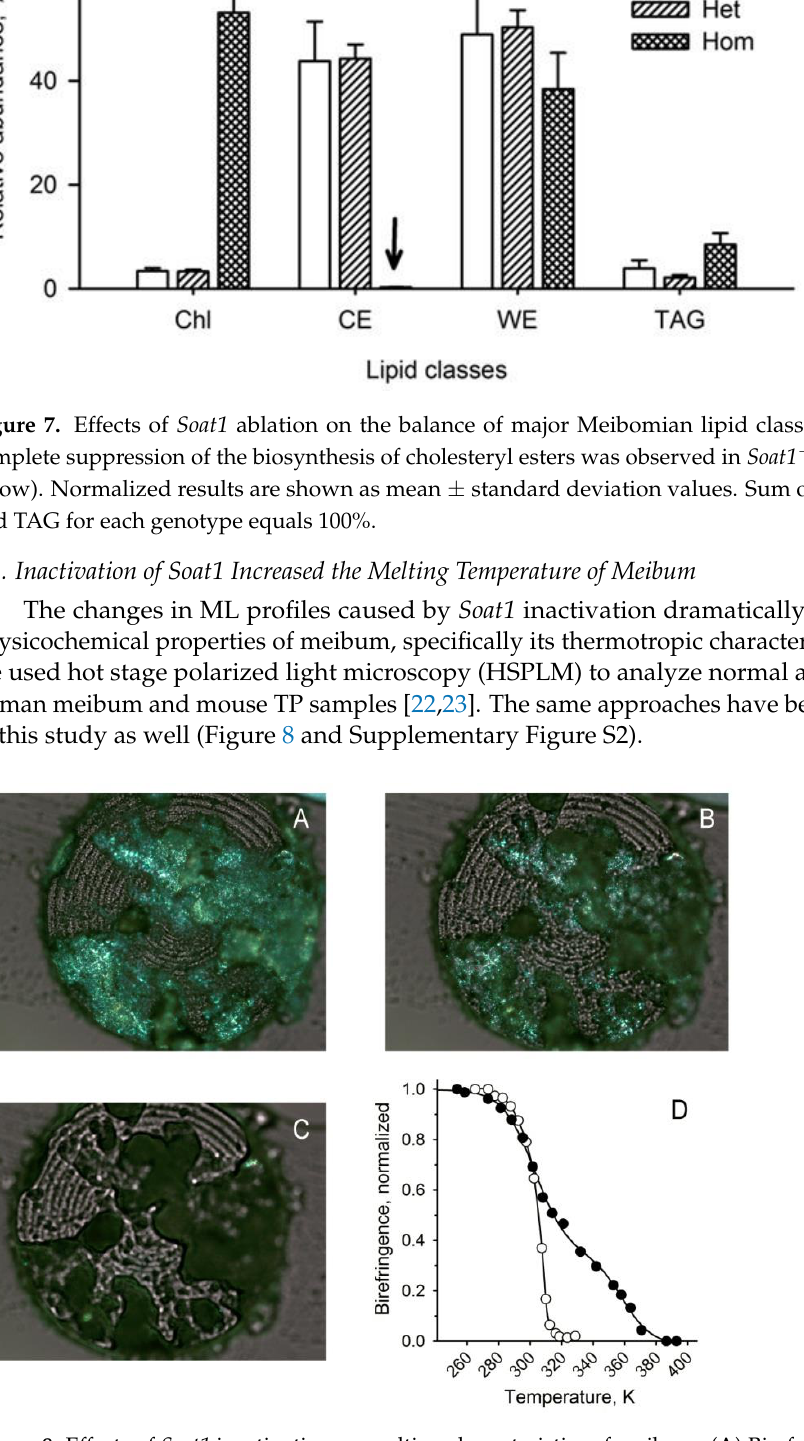
Figure 8. Effects of Soat1 inactivation on melting characteristics of meibum. ( A ) Birefringent pat- terns of solidified Soat1 -null mouse meibum at −25 °C; ( B ) partially melted Soat1 -null meibum at +50 °C; ( C ) almost completely melted, amorphous, non-birefringent Soat1 -null meibum at +125 °C; ( D ) melting curves of normal (open circles) and Soat1 -null (closed circles) meibum- Dots—experimental values; solid lines—theoretical curves computed using Equation (2) (see Ma- terials and Methods).